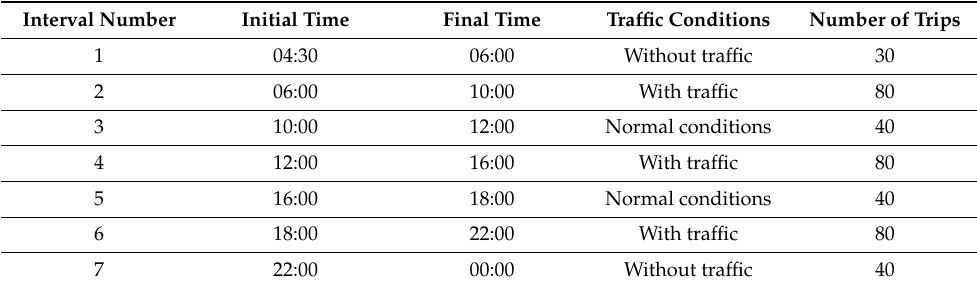
Table 3. List of route schedules with traffic